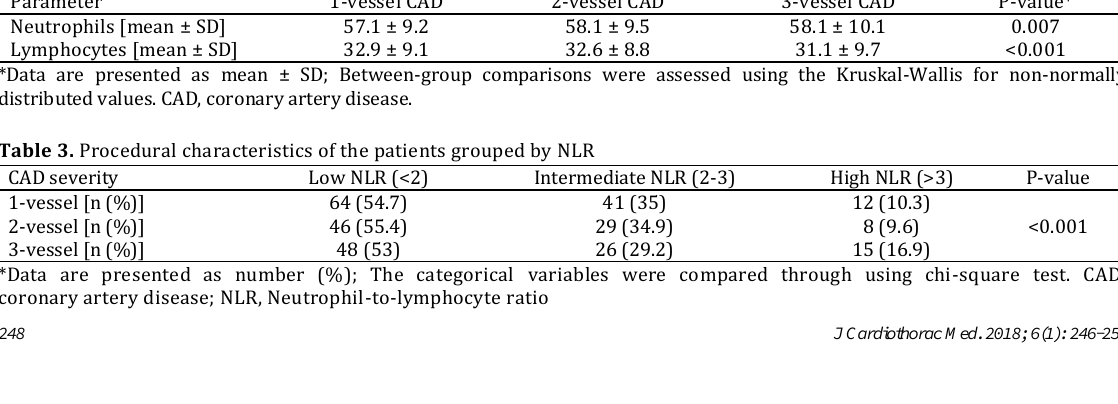
Table 2. Association of neutrophil and lymphocyte counts between CAD groups Parameter